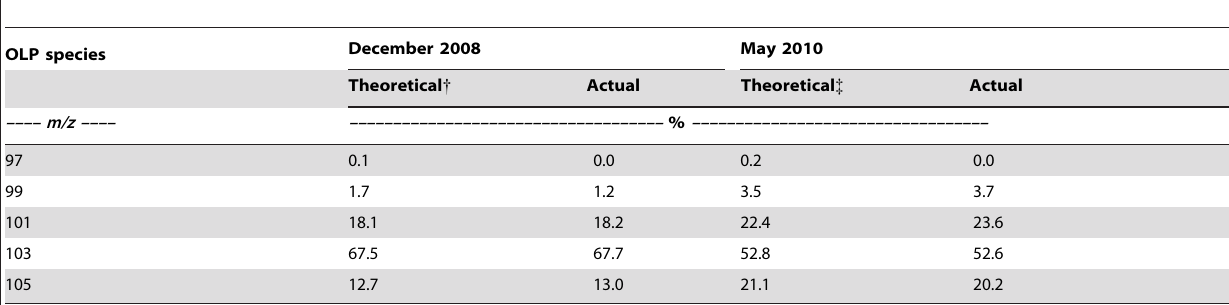
Table 5. Comparison between synthesis results and theoretical values of P-O bonds in POCl 3 broken during the synthesis of oxygen-18 labeled phosphate (OLP) using POCl 3